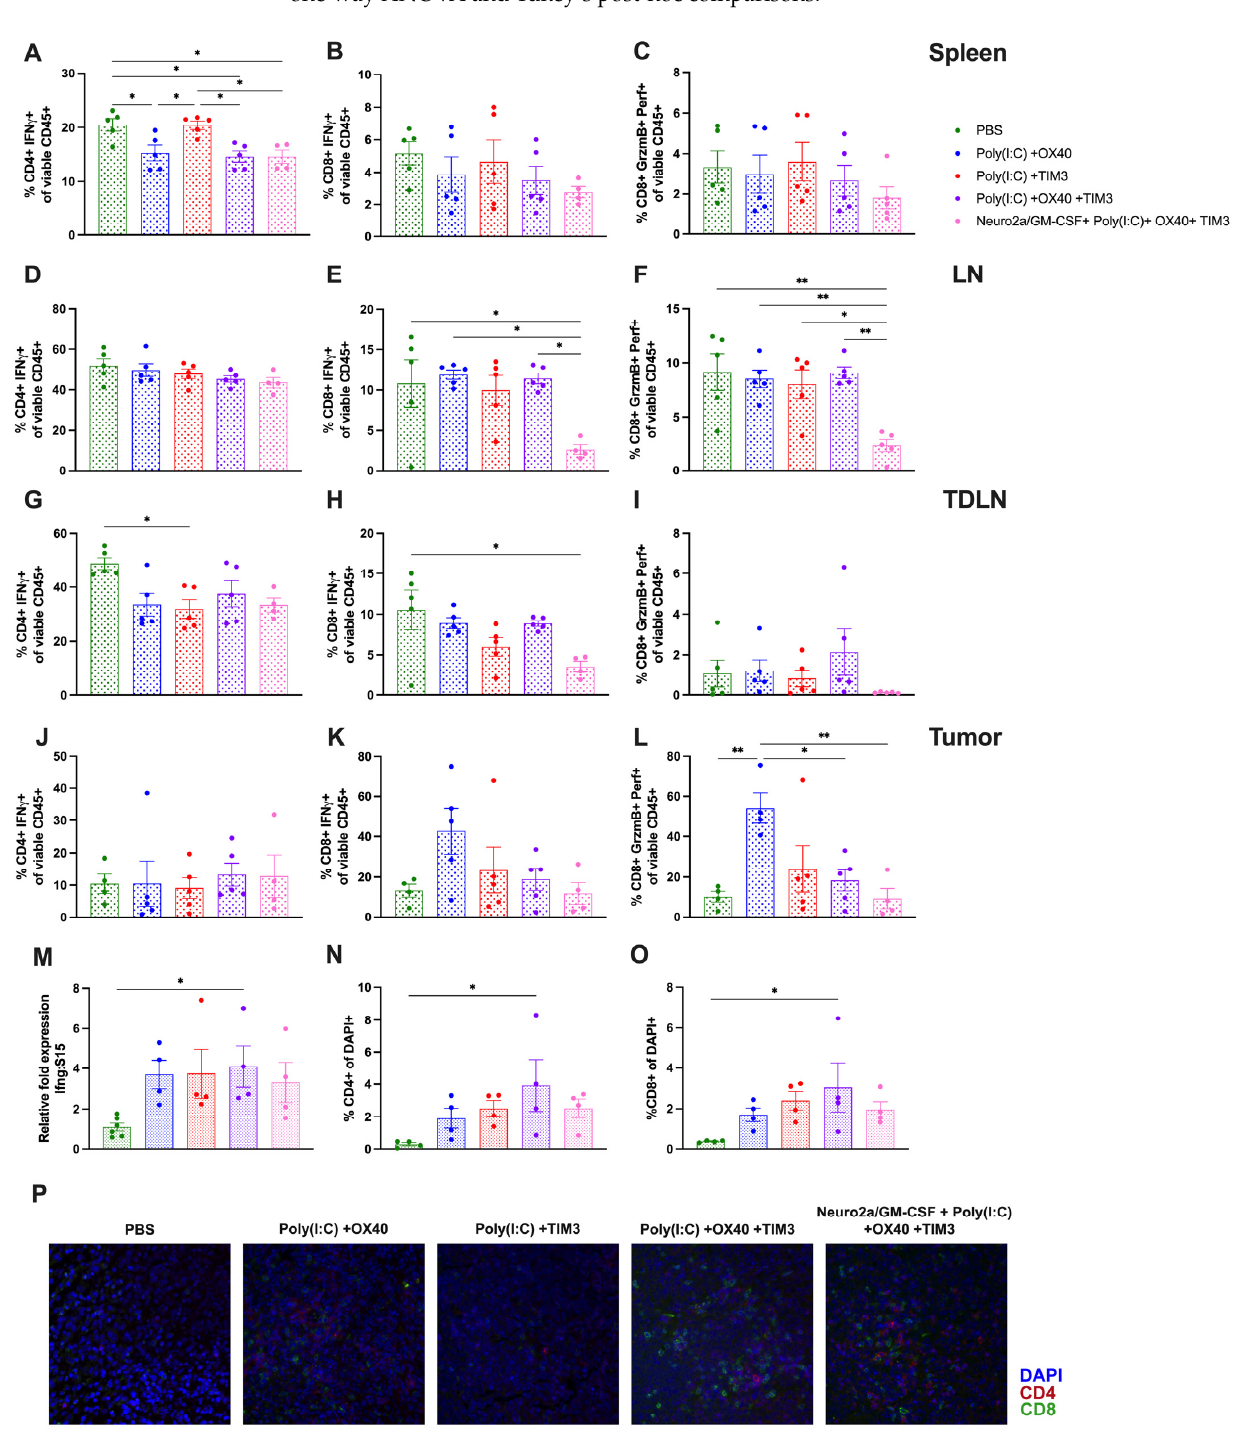
Figure 7. Markers of T-cell functionality are inconsistently altered across lymphoid tissues and in tumors 24 h following immunotherapy. ( A – C ) Spleens, ( D – F ) lymph nodes (LN), ( G – I ) tumor- draining lymph nodes (TDLN), and ( J – L ) tumors were harvested 24 h after the second immunother- apy dose and prepared for flow cytometric analysis as described in Section 2. All groups are pre- sented as a percentage of total viable CD45+ cells. Pro-inflammatory T cells were identified via the presence of interferon- γ (IFN- γ ) in ( A , D , G , J ) CD4+ T cells or ( B , E , H , K ) CD8+ T cells. ( C , F , I , L ) Active cytotoxic CD8 T cells were identified via co-expression of Granzyme B (GrzmB) and Perforin (Perf).